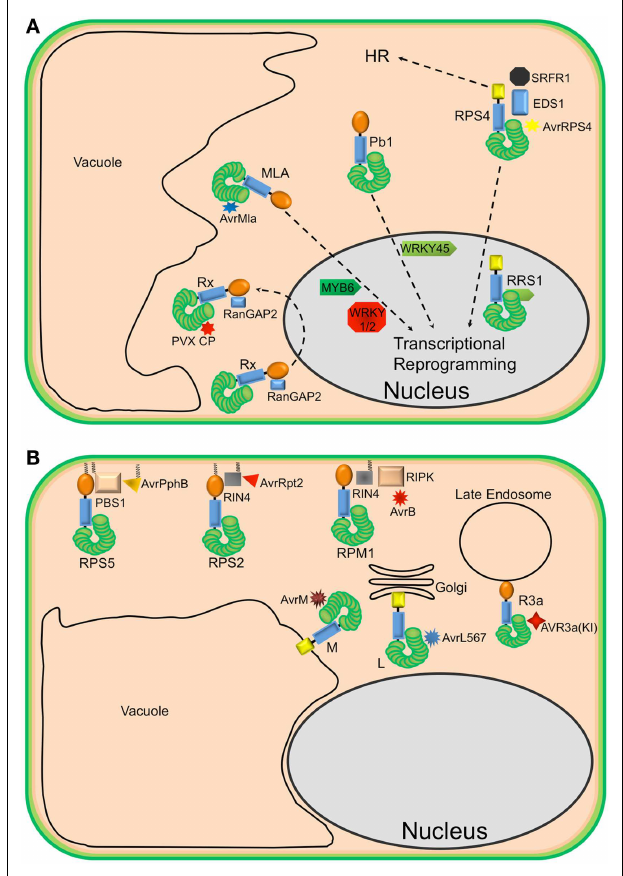
FIGURE 1 | Diverse localization of plant NLR proteins . (A) Nuclear-localized plant NLRs.The barley MLA proteins reside in the cytoplasm but, in the presence of corresponding AvrMla effectors, translocate into the nucleus where they interact with bothWRKY transcription repressors and MYB6, a transcriptional activator, to activate defense responses. Similarly, the rice CNL Pb1 also accumulates in the nucleus where it interacts with and stabilizes riceWRKY45 to activate defense responses. RPS4 also translocates into the nucleus, upon recognition of AvrRps4, to activate defense responses in conjunction with RRS1, an atypicalTNL in Arabidopsis that contains aWRKY domain. At the same time, a subset of RPS4 complexes stays in the cytoplasm to activate HR.The potato CNL, Rx, interacts with the cytosolic Ran GTPase Activating Protein 2 (RanGAP2) and actively shuttles between the nucleus and the cytoplasm. However, the recognition of PVX CP and activation of signaling seem to occur in the cytoplasm. (B) Endomembrane associated plant NLRs and their corresponding “guardees” and pathogen effectors. RPS5 (an NLR), PBS1 (guardee), and AvrPphB ( P. syringae effector) localize to the plasma membrane (PM).This is mediated by N-terminal acylation (myristoylation and/or palmitoylation). Similarly, RPS2 (an NLR) is PM-associated via a predicted N-terminal palmitoylation signal while RIN4 (guardee) localizes to the PM via a C-terminal prenylation or palmitoylation signal. RPM1 (NLR) also localizes to the PM, but lacks a predicted acylation signal.These three well-studied Arabidopsis NLR proteins are activated on the PM and initiate signaling on the PM. Relocalization following activation does not appear to occur.The flax rust resistance proteins L6 and M are respectively targeted to the Golgi apparatus and vacuolar membrane. Re-directing L6 to the vacuolar membrane, however, does not affect its function.The potato resistance protein, R3a, relocalizes from the cytoplasm to late endosomes in the presence of its corresponding effector AVR3a(KI), which also relocalizes to late endosomes in the presence of